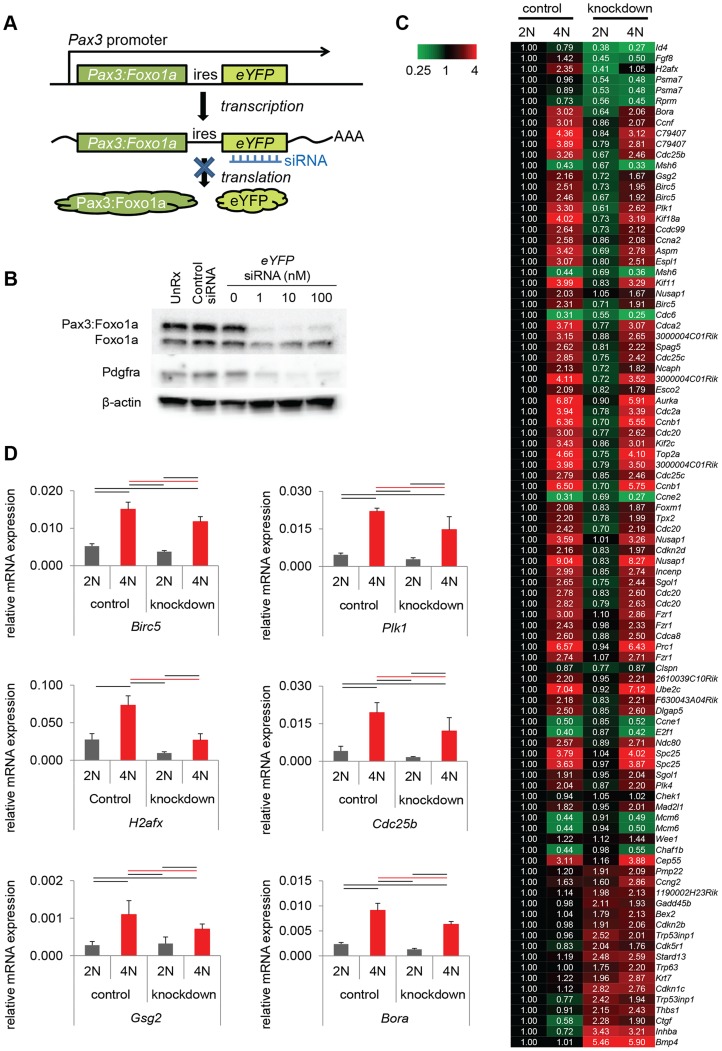
Pax3:Foxo1a induces G2/M checkpoint adaptation gene in G2/M.(A) Diagrammatic representation of Pax3:Foxo1a knockdown strategy using eYFP siRNA. (B) Knockdown of the Pax3:Foxo1a protein by siYFP. Total cell lysates were isolated 48 h after transfection. Pax3:Foxo1a was detected with an antibody targeting the C-terminus of Foxo1a. (C) Differential expression of 60 of cell cycle genes (as annotated by Gene Ontology) for DNA content with or without Pax3:Foxo1a knockdown. (D) mRNA expression by QPCR of Plk1, Cdc25b, H2afx and Birc5 normalized to Gapdh in DNA content-sorted U23674 mouse aRMS primary tumor cells with or without Pax3:Foxo1a knockdown. Black and red line shows significant difference (p<0.05).